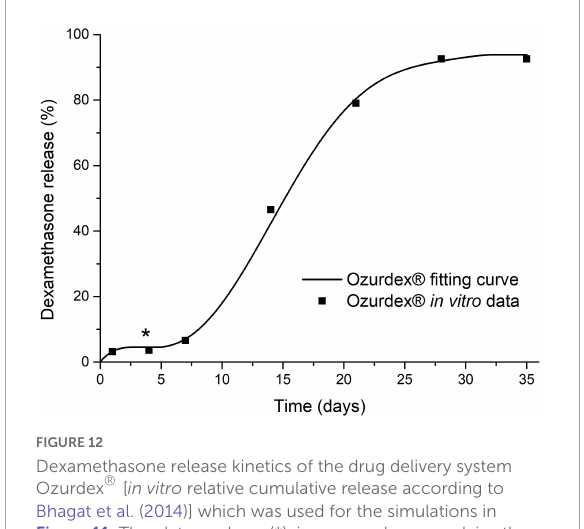
FIGURE12 Dexamethasone release kinetics of the drug delivery system Ozurdex R (cid:13) [ in vitro relative cumulative release according to Bhagat et al. (2014)] which was used for the simulations in Figure 11 . The plateau phase (*), i.e., zero release, explains the “dip” in the intracochlear concentration-time-distance curves in Figures 11C–F